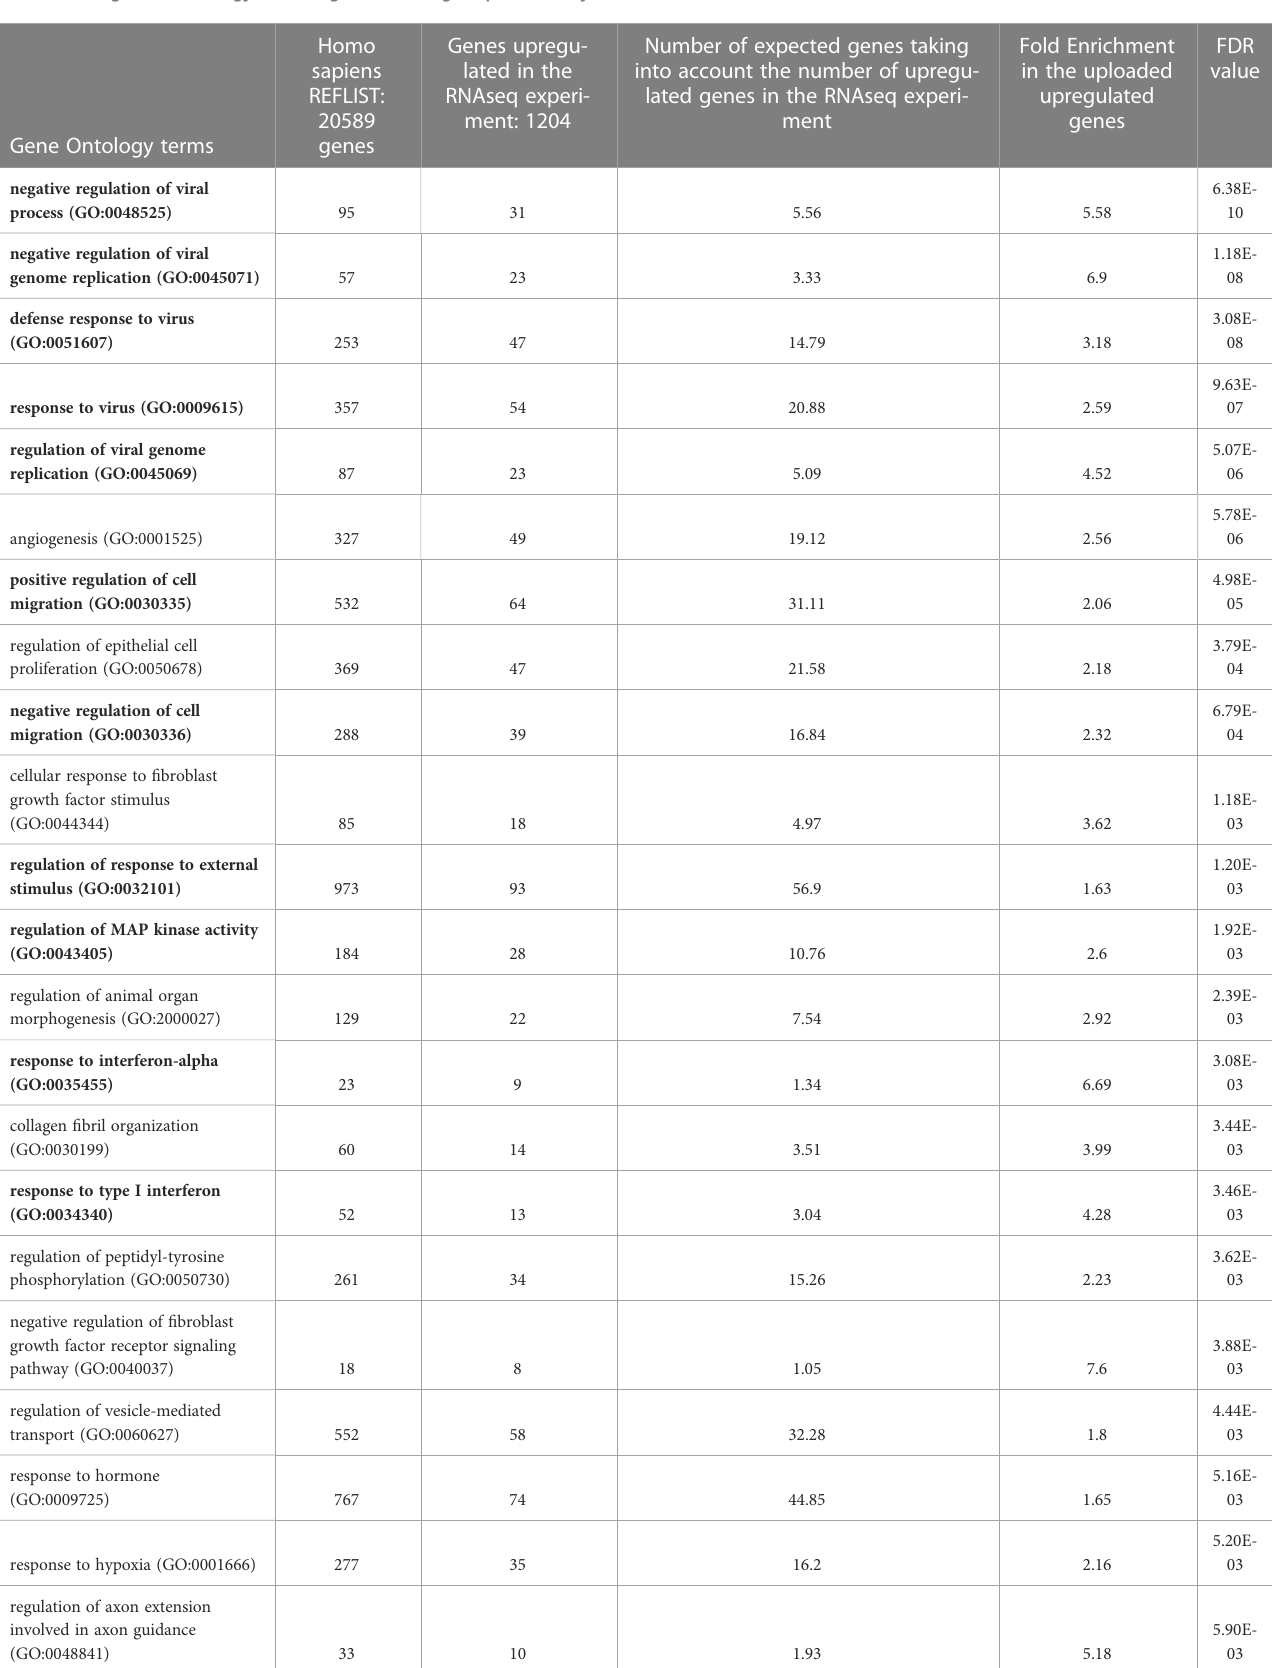
Fold Enrichment FDR in the uploaded upregulated genes